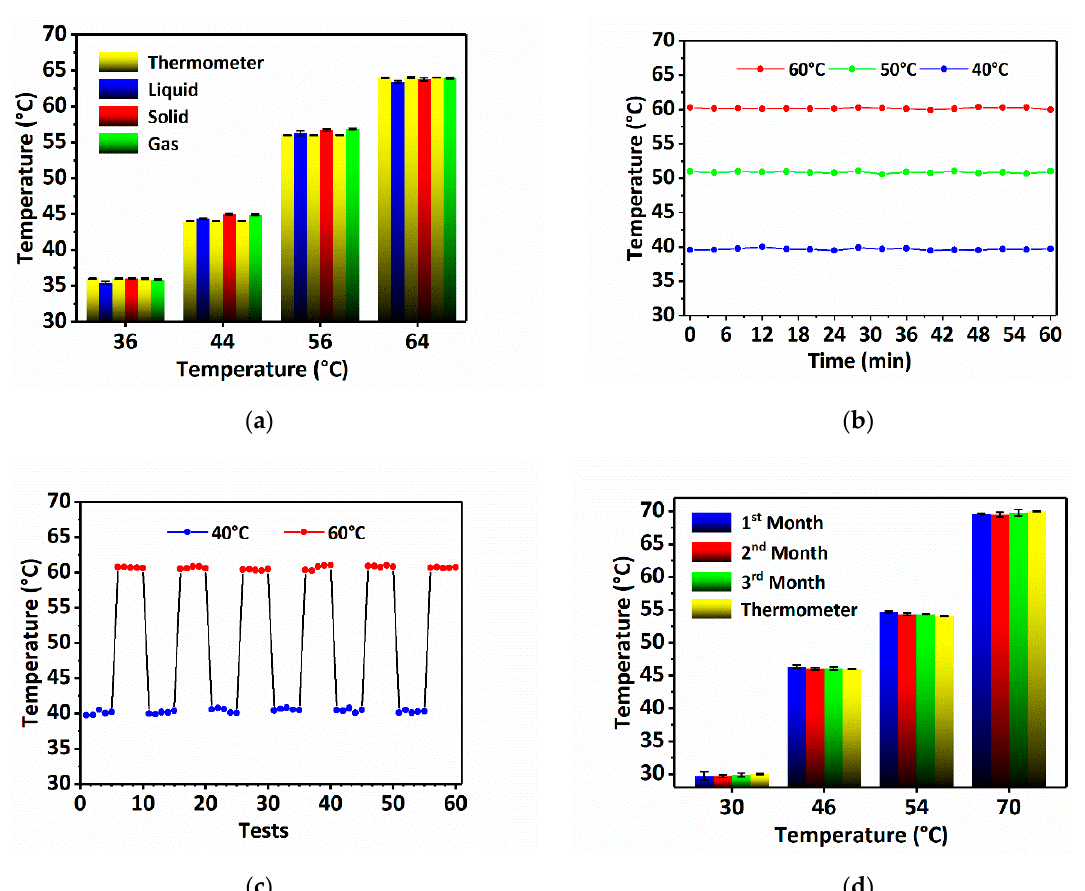
Figure 6. Sensor performance verification. ( a ) Accuracy verification; ( b ) stability verification; ( c ) repeatability and time response verification; ( d ) conservation time verification.